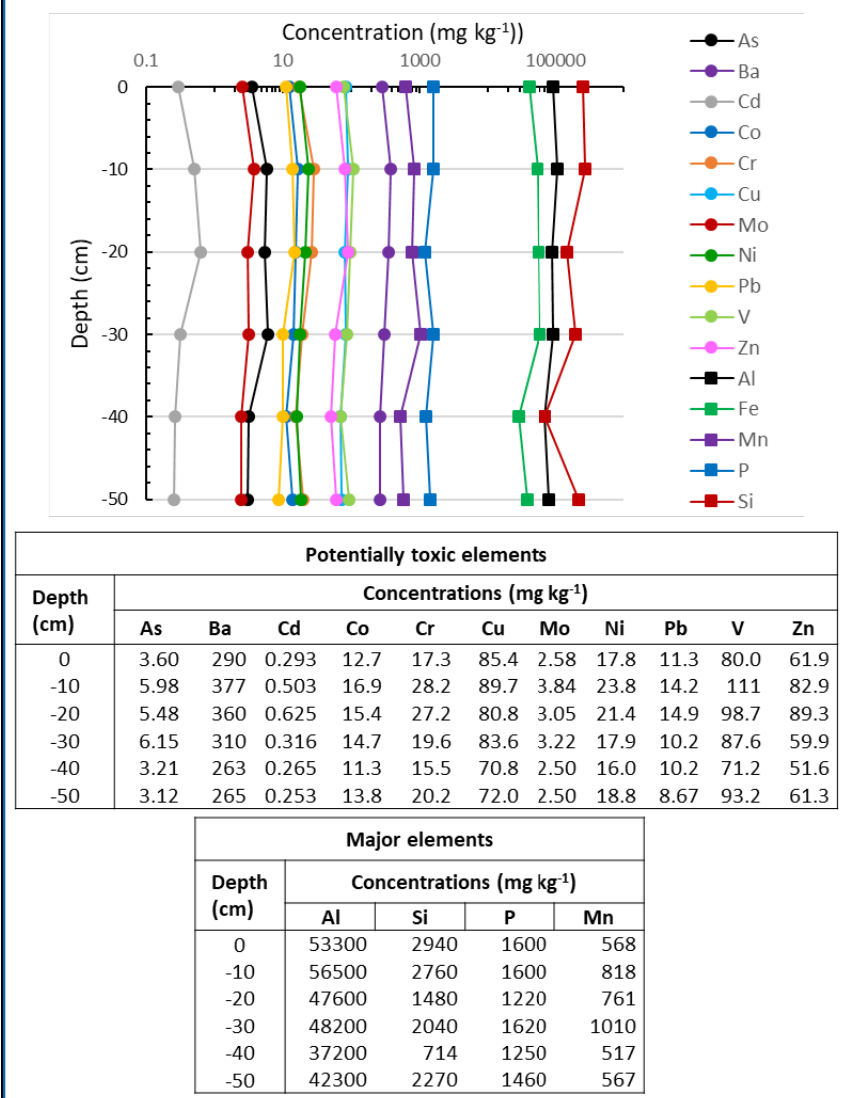
Figure 3. Vertical distribution of minor and major elements concentration in the Limoncocha lagoon core. Table 2. Minimum concentrations of minor and major analyzed elements in the sediment core of the center of the lagoon in comparison to surface sediment concentrations.